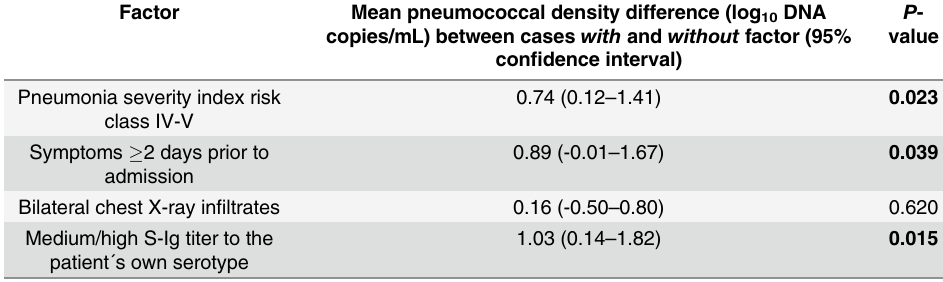
Table 3. Factors and their independent association with nasopharyngeal pneumococcal density. Regression analysis with bootstrapping in 47 patients with complete information about the included